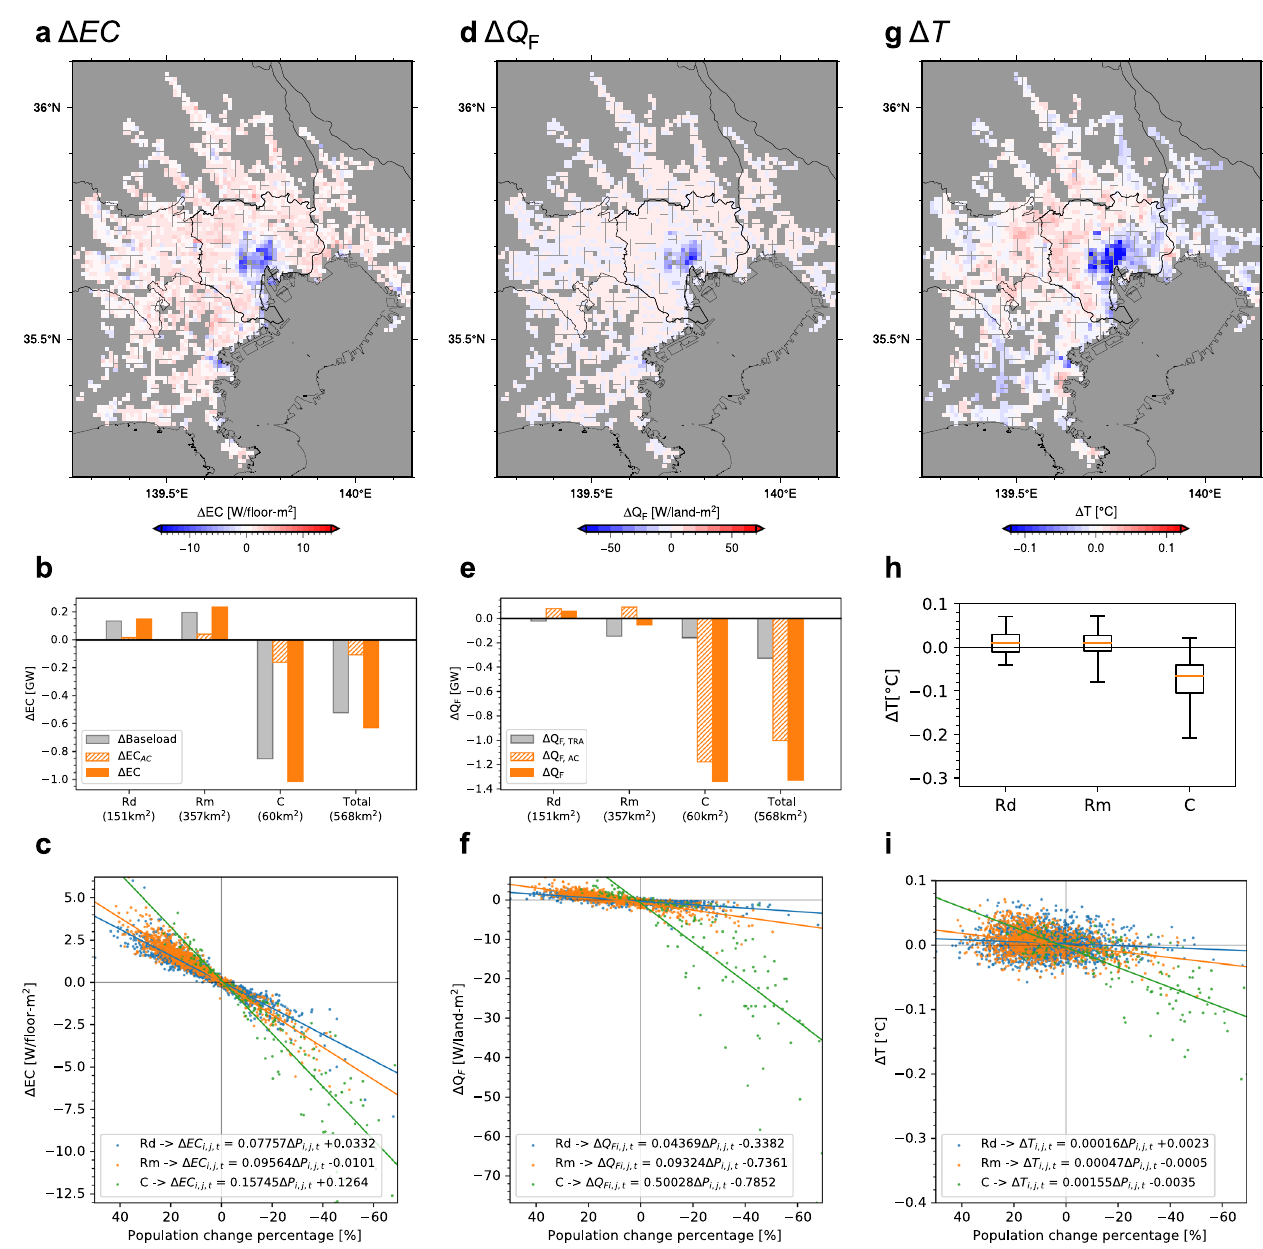
Fig. 2 Impact of COVID-19 on urban climate. Horizontal variation in the impact of COVID-19 on a energy consumption ( EC ) ( Δ EC ), d anthropogenic heat ( Q F ) ( Δ Q F ) and g near-surface air temperature ( T ) ( Δ T ) as a daytime average for the period of 18 April to 14 May 2020. Bar charts and box plots of b Δ EC , e Δ Q F and h Δ T for each urban category and the total for the 23 wards of Tokyo (bold black line in a , d , and g ). The relationship between population changes and c Δ EC , f Δ Q F and i Δ T for each urban